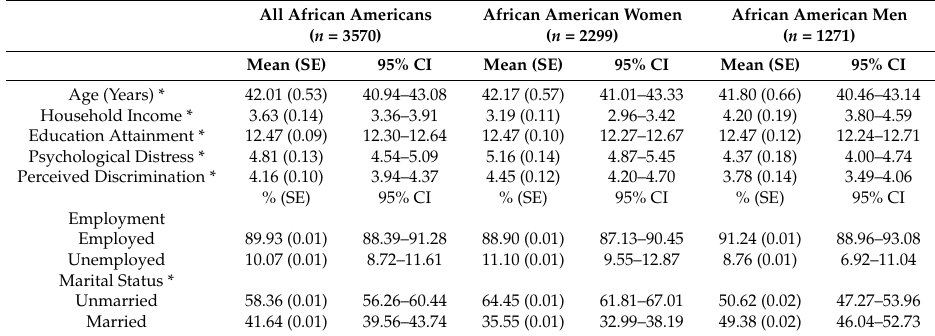
Table 1. Descriptive statistics in the pooled sample and by gender among African American adults.